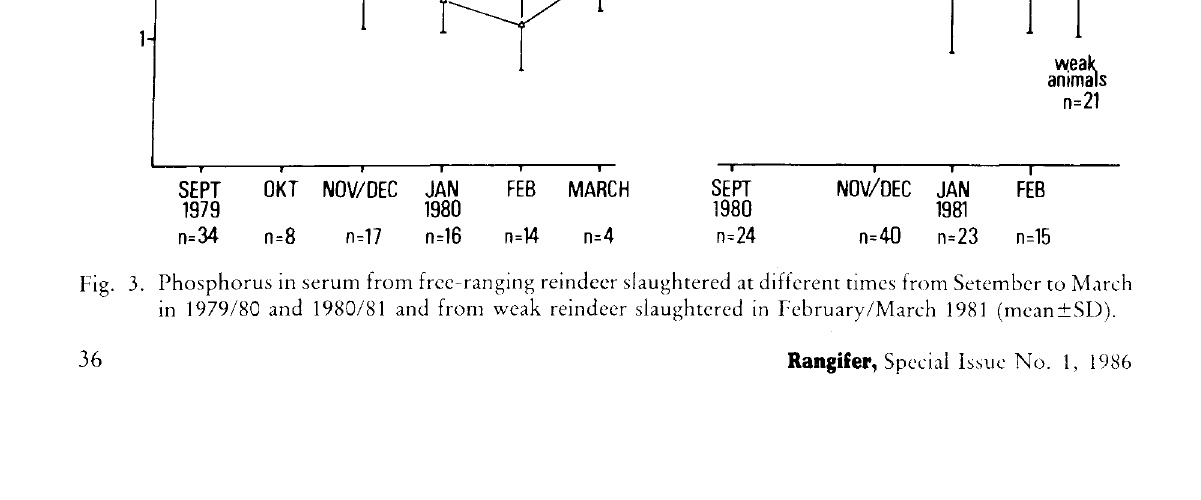
Fig. 3. Phosphorus in serum from free-ranging reindeer slaughtered at different times from Setember to March in 1979/80 and 1980/81 and from weak reindeer slaughtered in February/March 1981